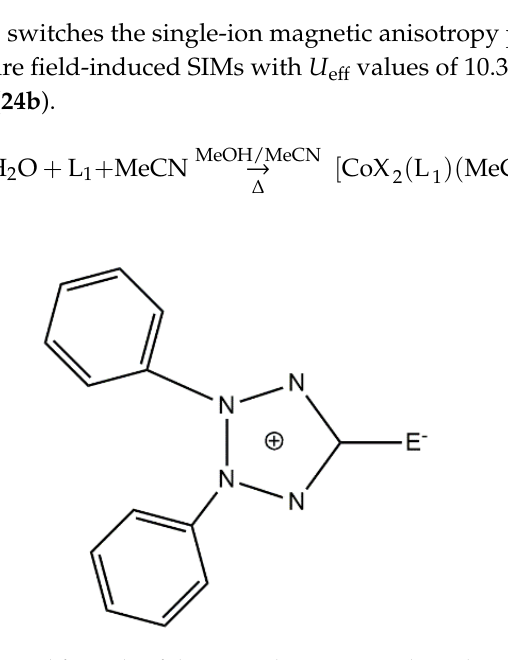
Figure 14. The general structural formula of the exocyclic mesoionic ligands L 1 (E = O) and L 2 (E = S).